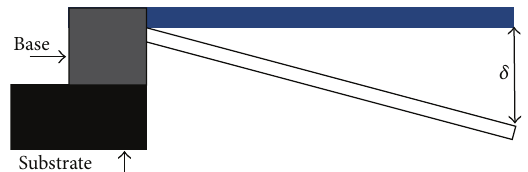
Figure 1: Static and deflected positions of a rectangular cantilever